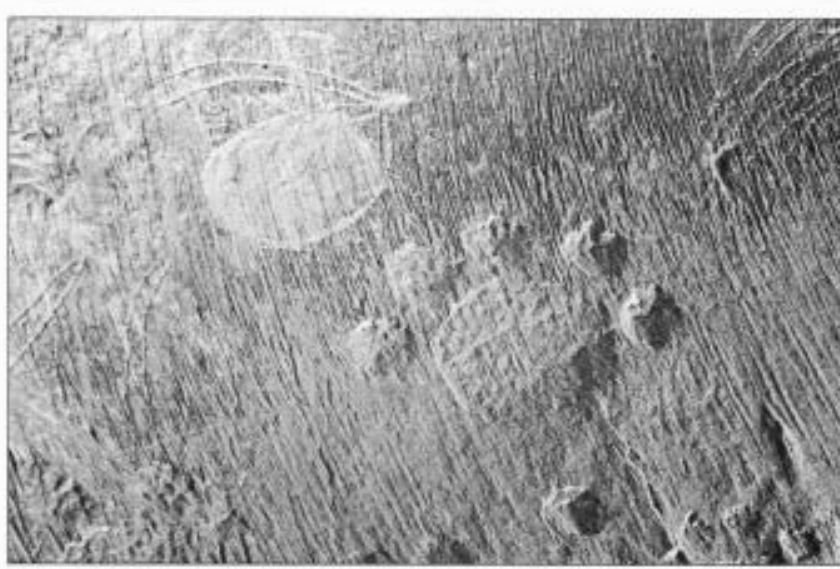
Figure 7 Rock engravings of an animal resembling a pregnant(?) oryx and a pattern of round depressions arranged in the "lion foot" motif, El Obeiyed cavern,